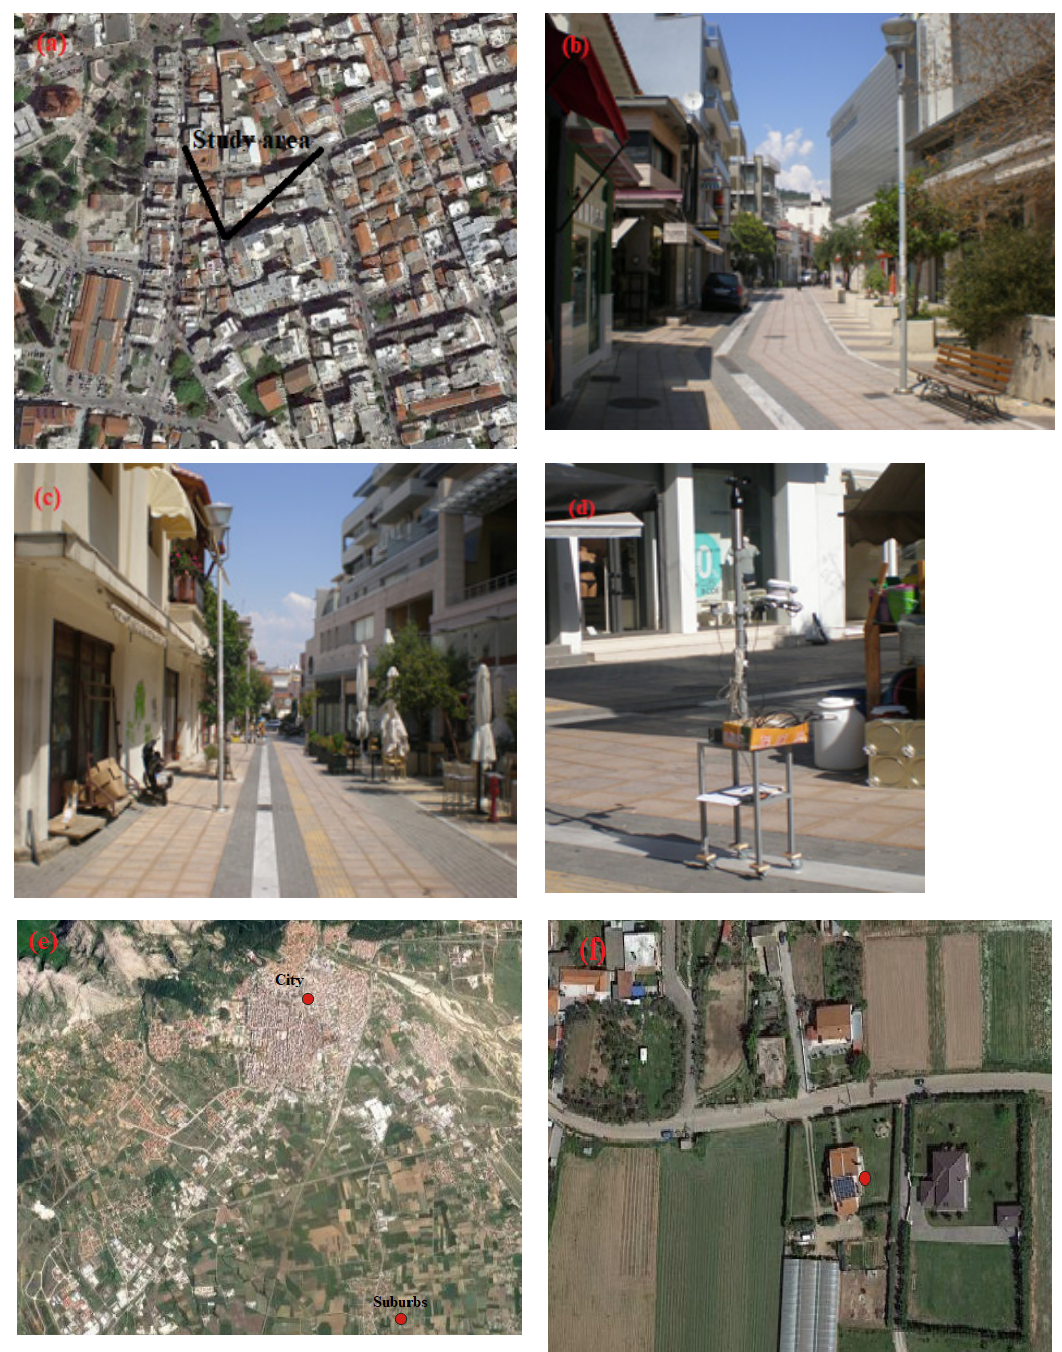
Figure 1. Overview of the study area: ( a ) Region of Xanthi; ( b ) Dagli Str; ( c ) Elpidos Str; ( d ) Meteorological station in the study area; ( e ) Location of the Meteorological Stations in the city and suburb (red points); ( f ) Location of the Meteorological Station of National Observatory of Athens (red point).